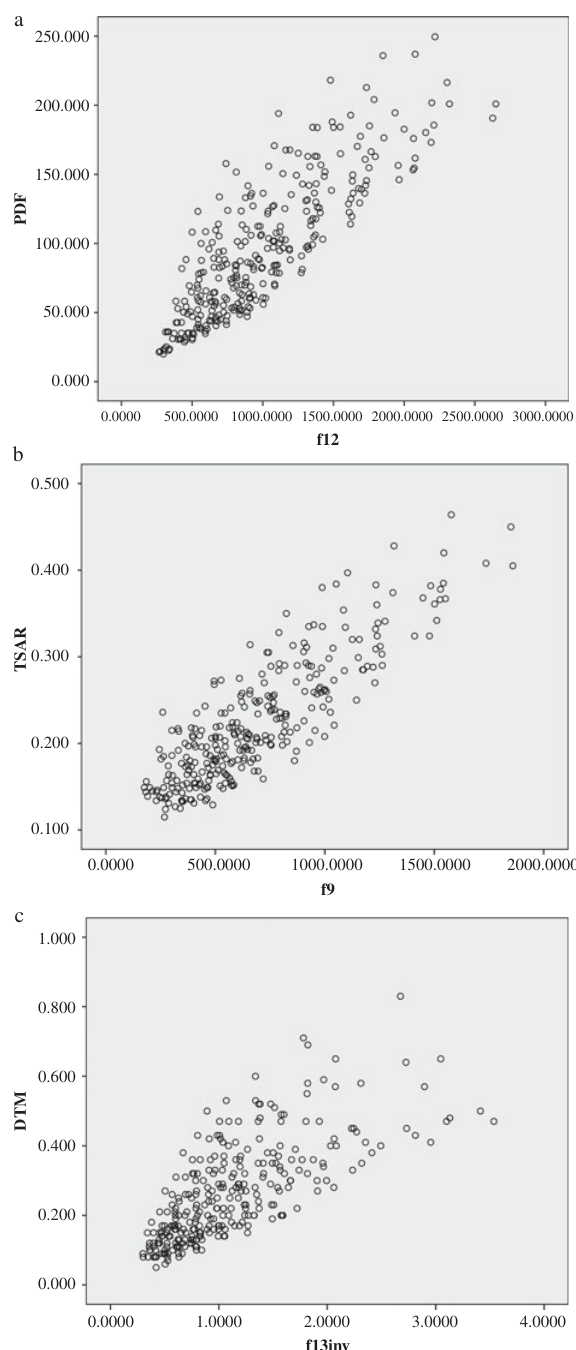
Fig. 10. Magnified scatter plots of: (a) P DF vs. f 12 , (b) TSAR vs. f 9 , (c) D TM vs. f